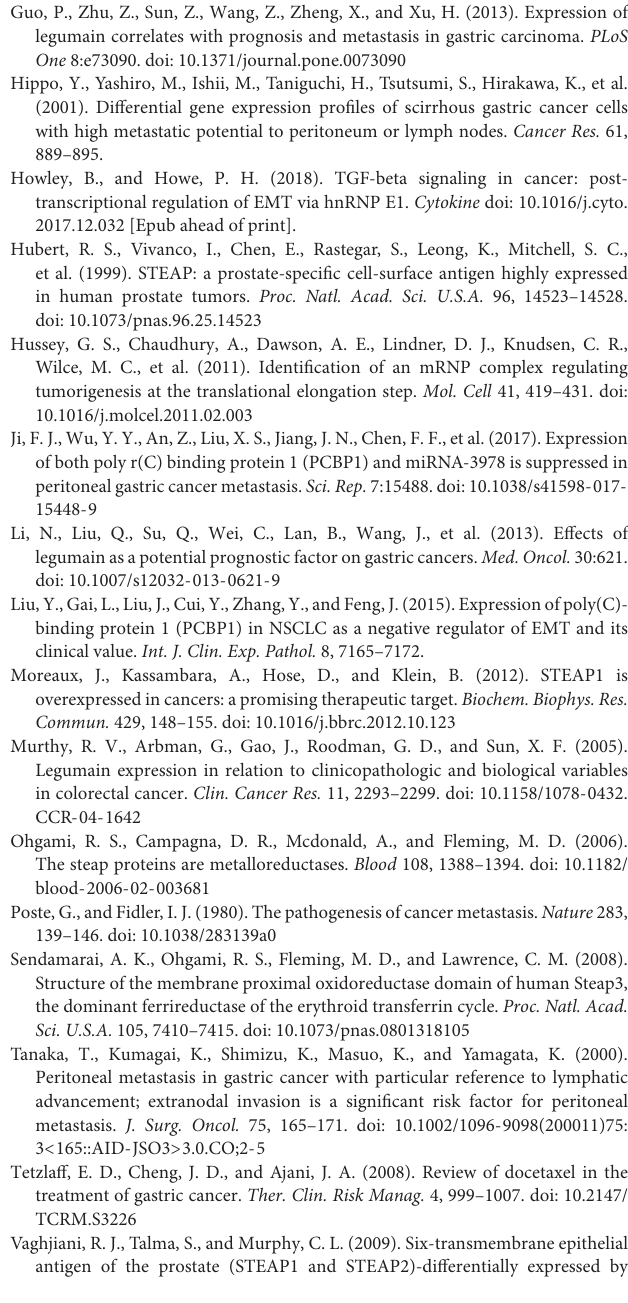
FIGURE S1 | Efficiency of shRNA-1 and 2 targeting STEAP1 to downregulate STEAP1 expression. Relative mRNA expression of STEAP1 , normalized to GAPDH expression, in parental MKN45 cells and MK N45 cells stably transduced with two different shRNAs (shRNA-1 and shRNA-2) targeting STEAP1 . Data represents mean ± standard deviation of three independent replicates. ∗ p < 0.05. TABLE S1 | Genes showing 2-fold changes in polysome occupancy between tumor and tumor adjacent normal gastric cancer tissue with peritoneal metastasis. TABLE S2 | Genes showing 2-fold changes in polysome occupancy in the normal human mesothelial cell line, HMrSV5, either mock transfected or transfected with anti-miR-3978